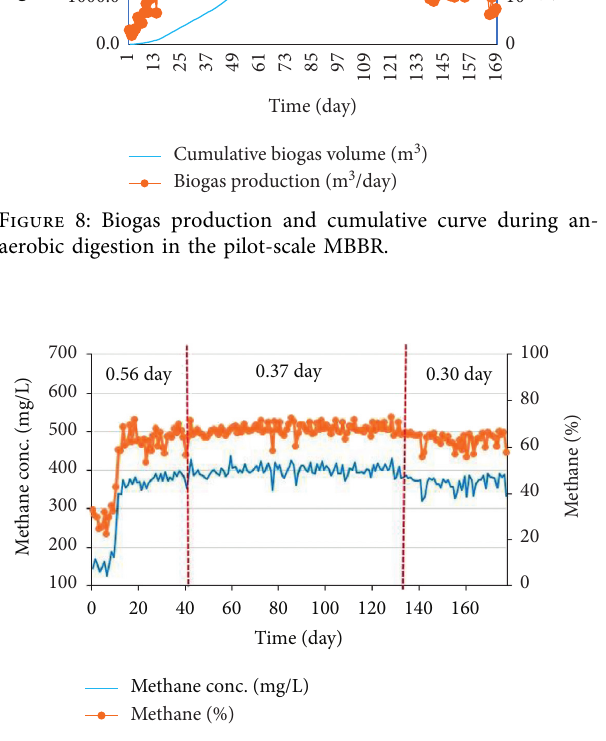
Figure 9: Methane content in biogas produced from the pilot-scale